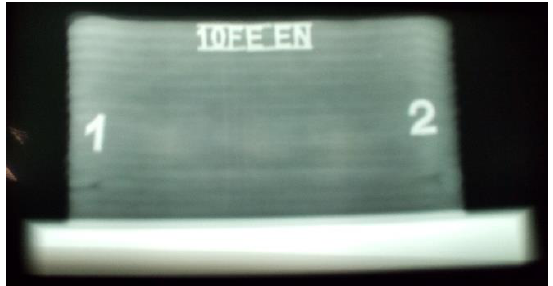
Figure 6. X-ray photo showing the absence of defects in manufactured wall. WAAM parts were thermally treated at three different temperatures: 710 ◦ C for 4 h, as conventional stress relieving heat treatment, and 850 ◦ C and 920 ◦ C for 5 h, all at high vacuum (<10 − 4 mbar). The temperature profiles are represented in Figure 7. Walls at properties and microstructure after heat treatments.